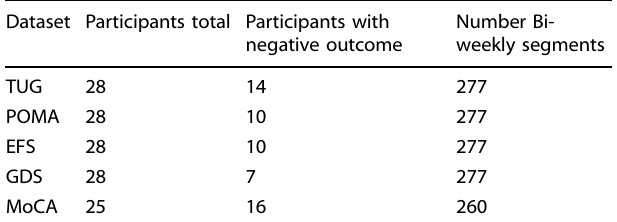
Table 6. Dataset Characteristics.